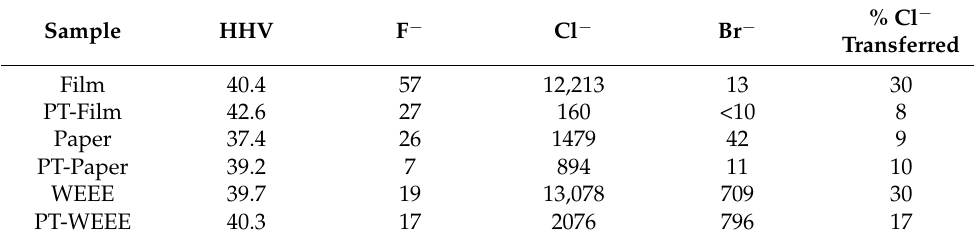
Table 7. HHV (MJ kg − 1 ) and halogen content (ppm) of the organic fraction of pyrolysis oils.